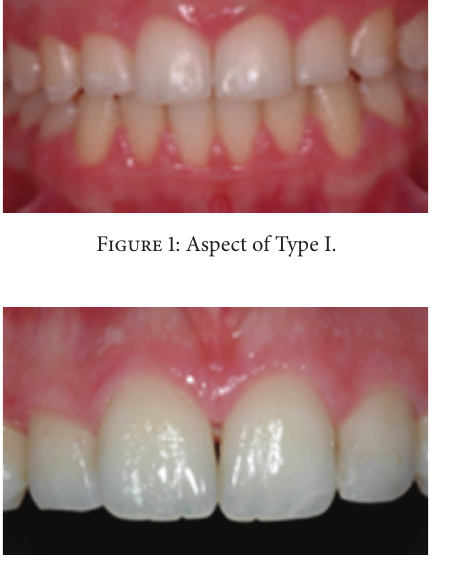
Figure 2: Aspect of Type II.